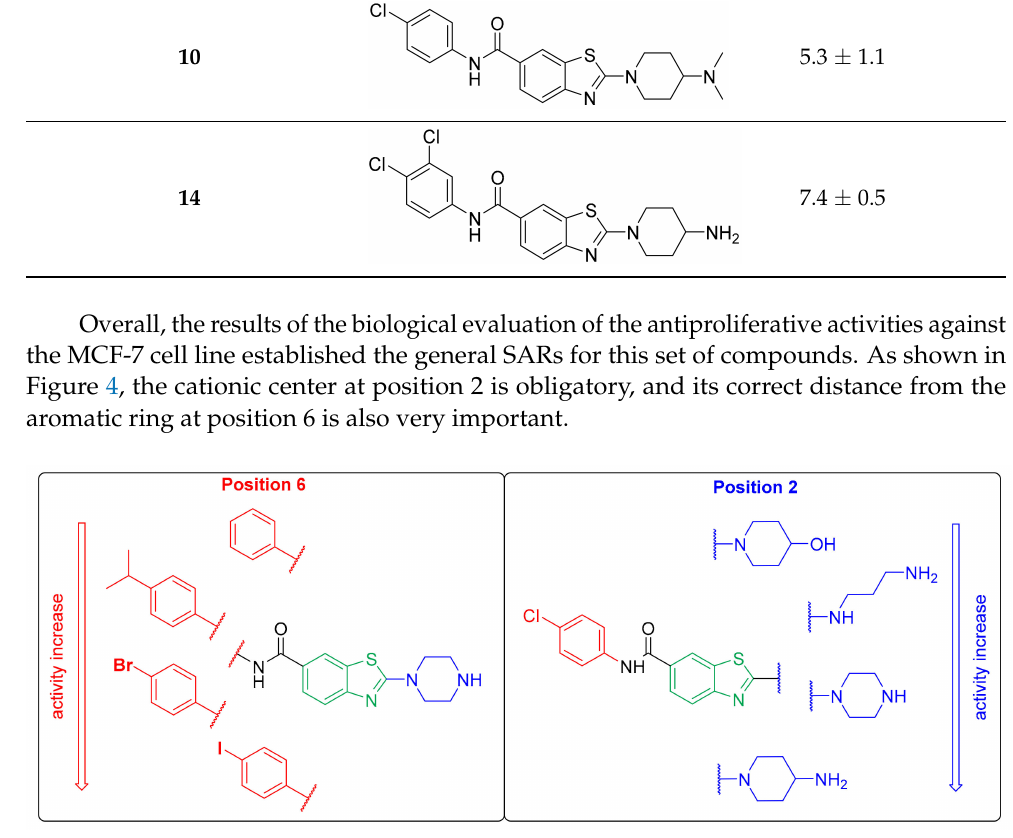
Figure 4. Structure–activity relationships of the benzothiazole based Hsp90 C-terminal-domain